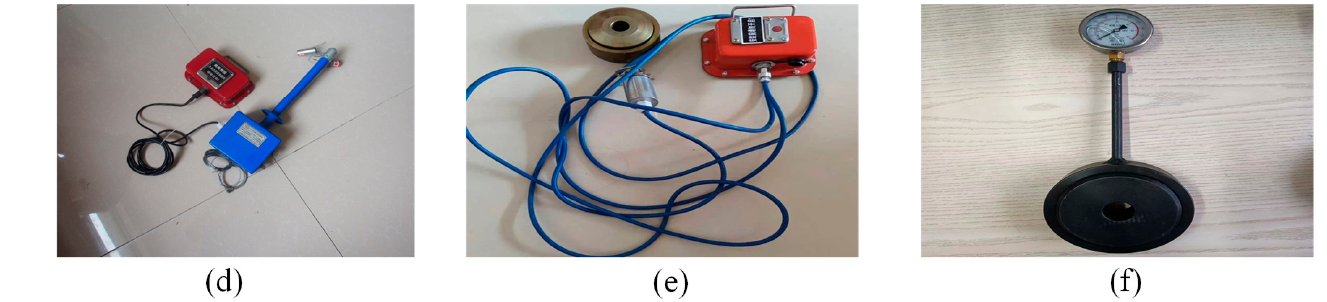
Figure 26. Engineering monitoring instruments: ( a ) detection equipment for internal fracture of the coal mass, ( b ) industrial CT scanning system, ( c ) roadway surface displacement monitoring equipment, ( d ) roof abscission layer instrument, ( e ) borehole stress gauge, and ( f ) anchor cable dynamometer.